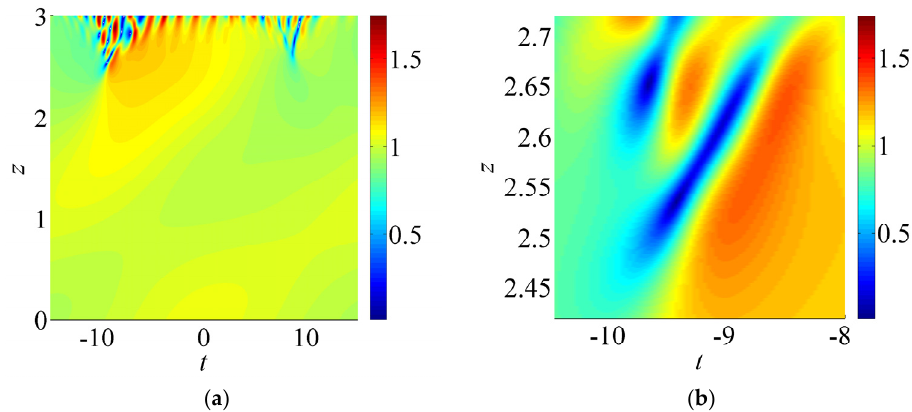
Figure 5. ( a ) The q ‐ component of the simulated RW mode for Equation (7) with σ ’ = 10, ρ = 1, δ ’ = 5 and γ = 2; ( b ) an enlarged view of a RW ‐ like structure in ( a ). The frequency K of the single mode disturbance is 0.2.